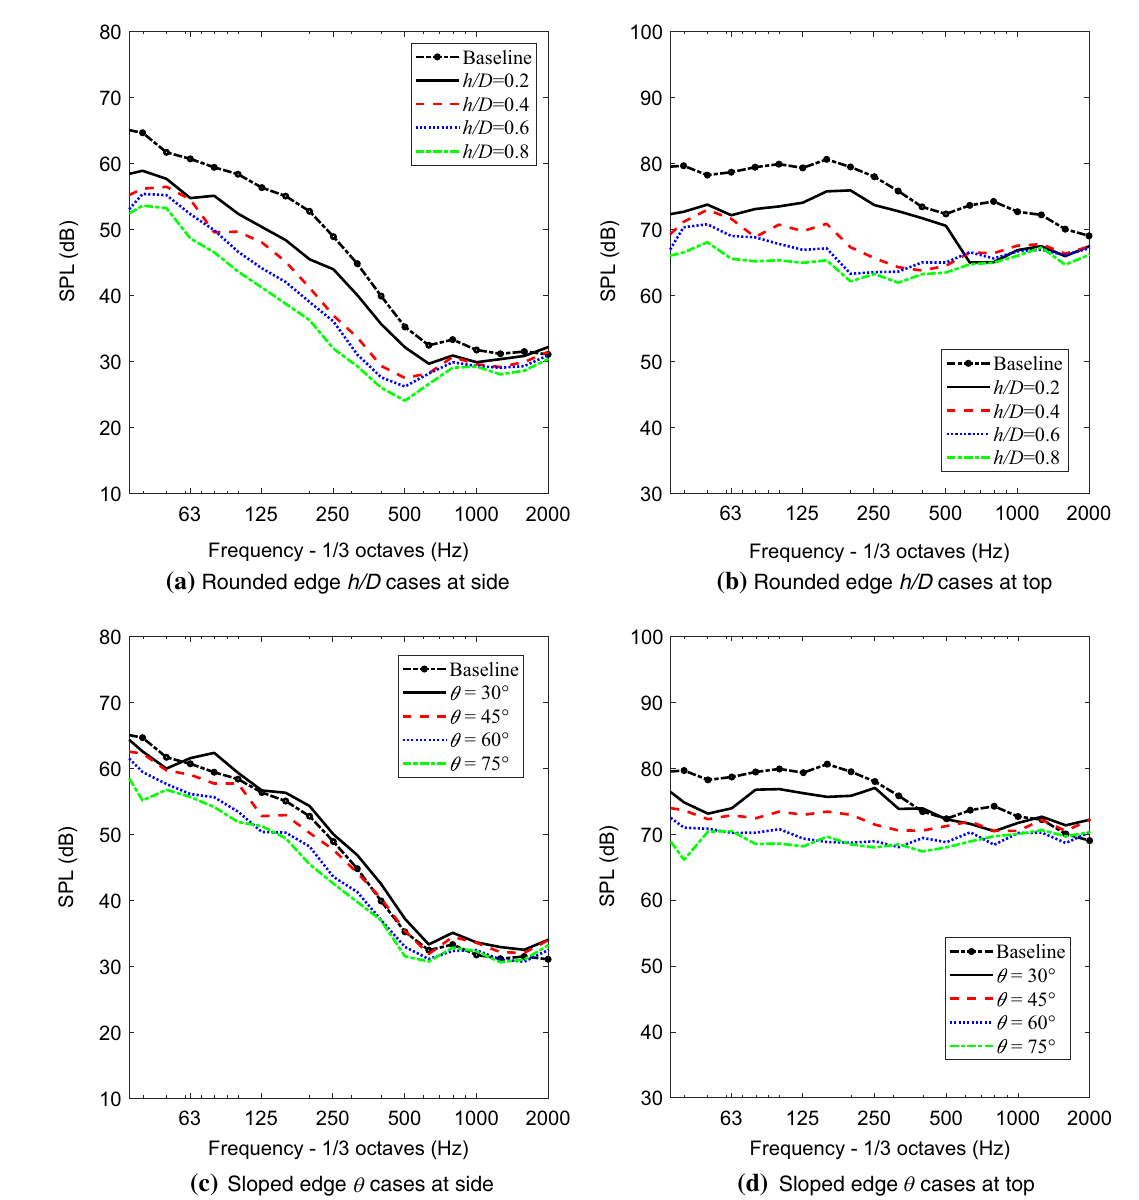
Fig. 10 Sound pressure levels at the side